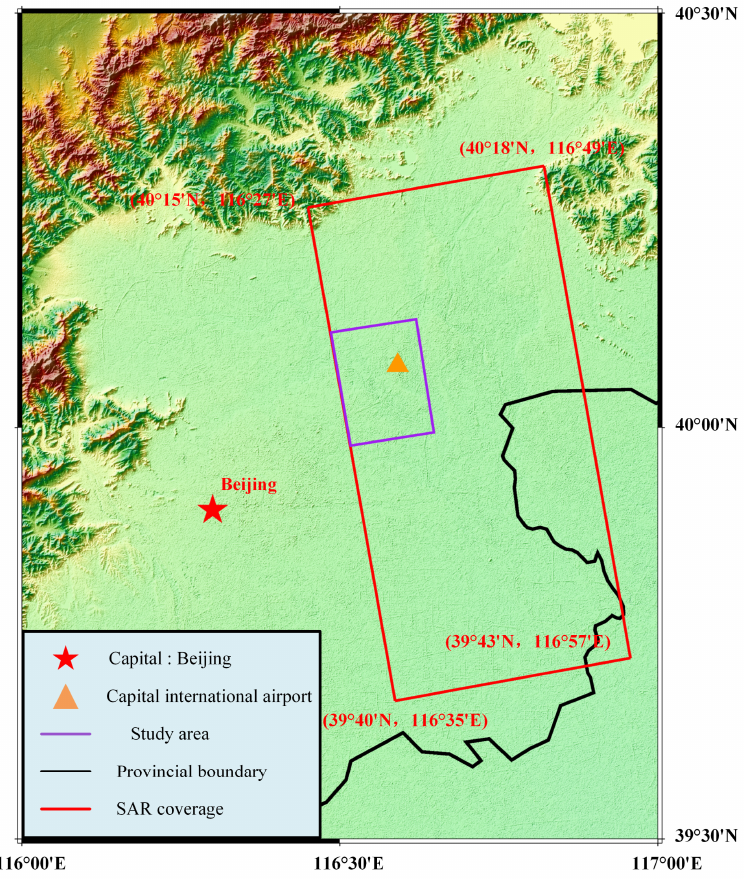
Figure 4. The geographic location of the study area.